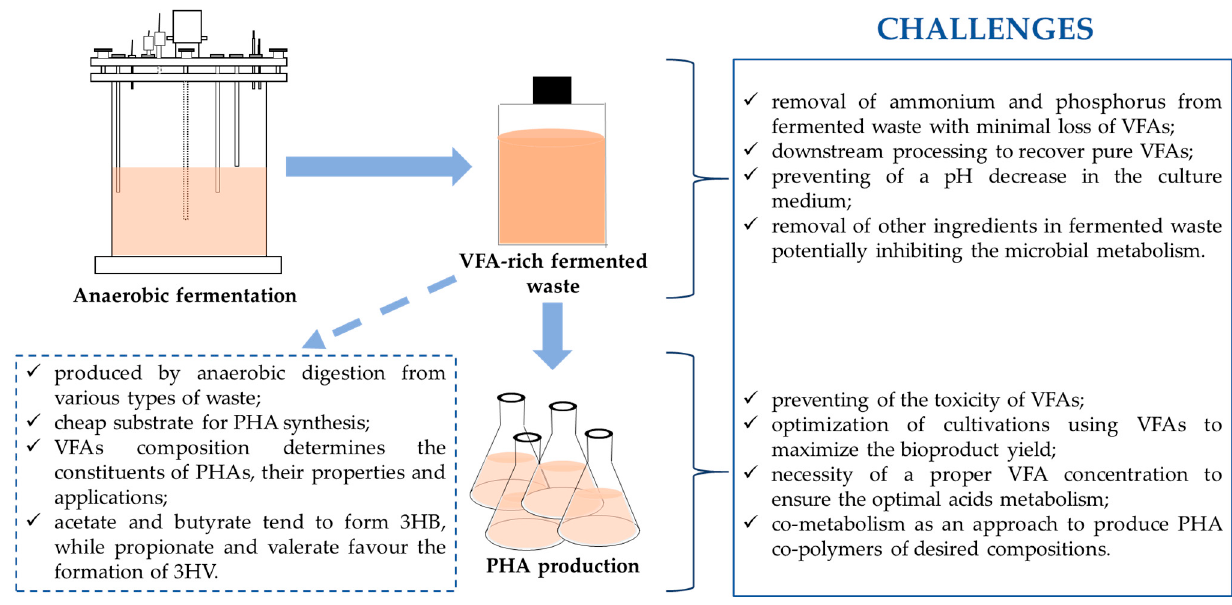
Figure 3. Challenges in producing polyhydroxyalkanoate biopolymers using VFAs.